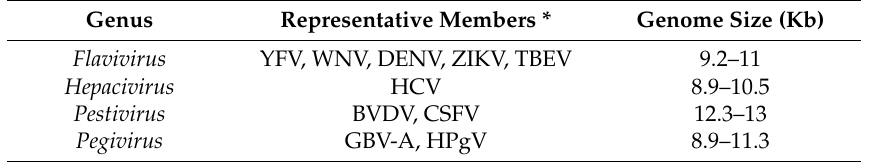
Table 3. Members of the Flaviviridae family. The four genera, with representative members and genome size corresponding to each genus, are